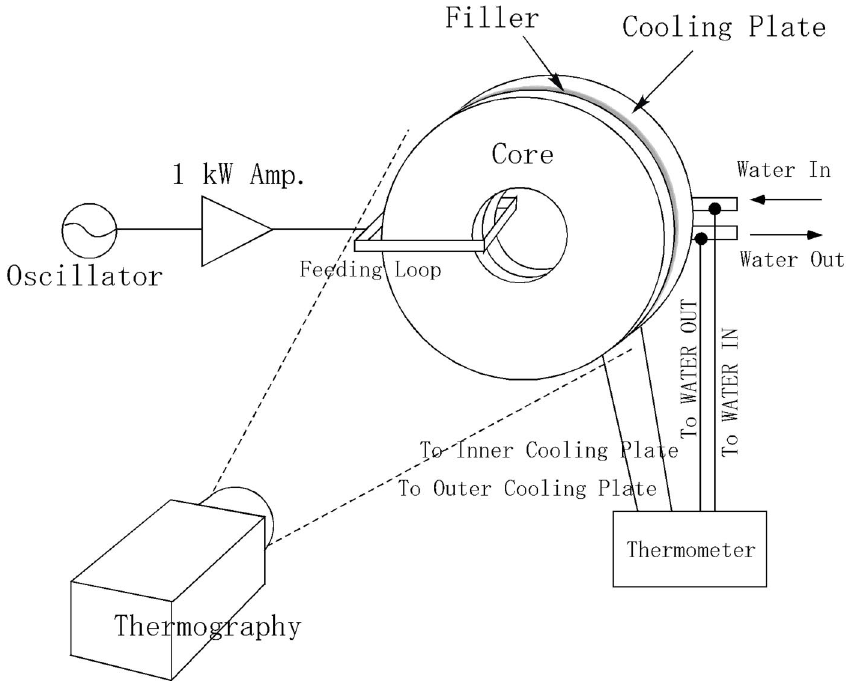
FIG. 7. Cooling experiment setup.